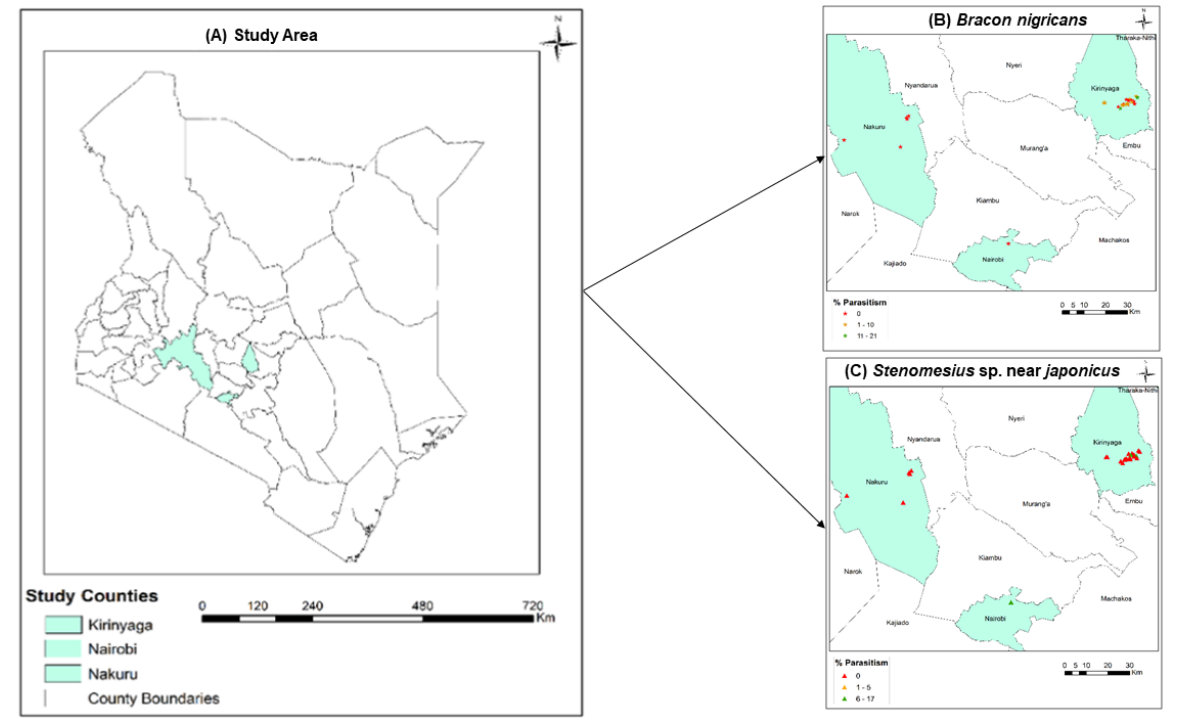
Figure 4. Maps showing ( A ) the study area, ( B ) Bracon nigricans parasitism rate, and ( C ) Stenomesius sp. nr. japonicus parasitism rate, within the sampling sites. Table 1. Description of T. absoluta emergence per kilogram of infested leaves and the corresponding parasitism rate for each species in the 2020 and 2021 collections.